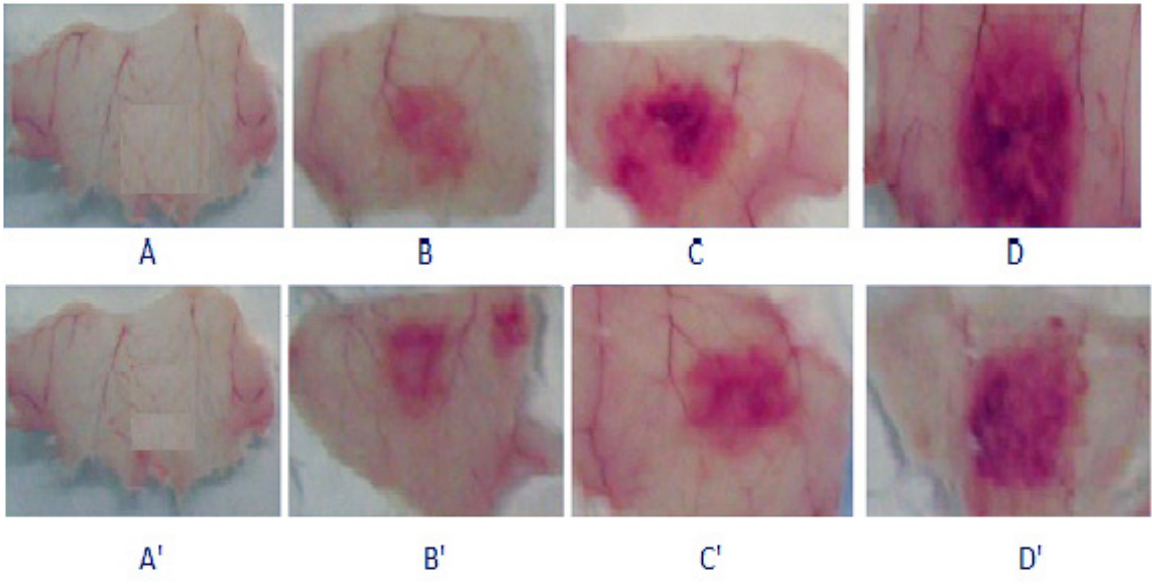
Figure 2. Recording of hemorrhagic activity of Cerastes cerastes (A, B, C, D) and Macrovipera mauritanica venoms (A’, B’, C’, D’) of the “skin-test.” This activity is dose dependent. A and A’: control; B and B’: 5 μg; C and C’: 10 μg; D and D’: 20 μg of injected venom.